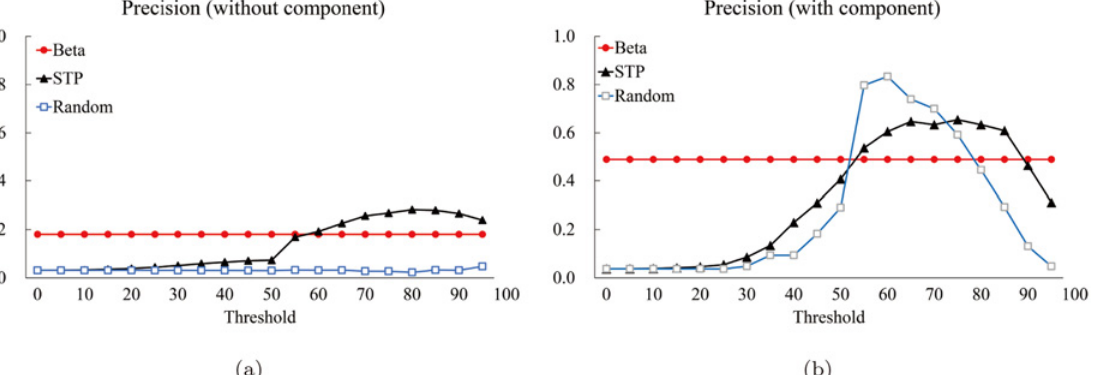
Fig 18. The precision graphs. The red circle corresponds to the proposed method. The black triangle and blue square correspond to the average value (of the 85 structures of the Astex Diverse Set) for the STP and Random methods for each threshold value, respectively. The horizontal and the vertical axes denote the thresholds and the computed values of precision, respectively. (a) Precision for “ Without (component) ” and (b) one for “ With (component).